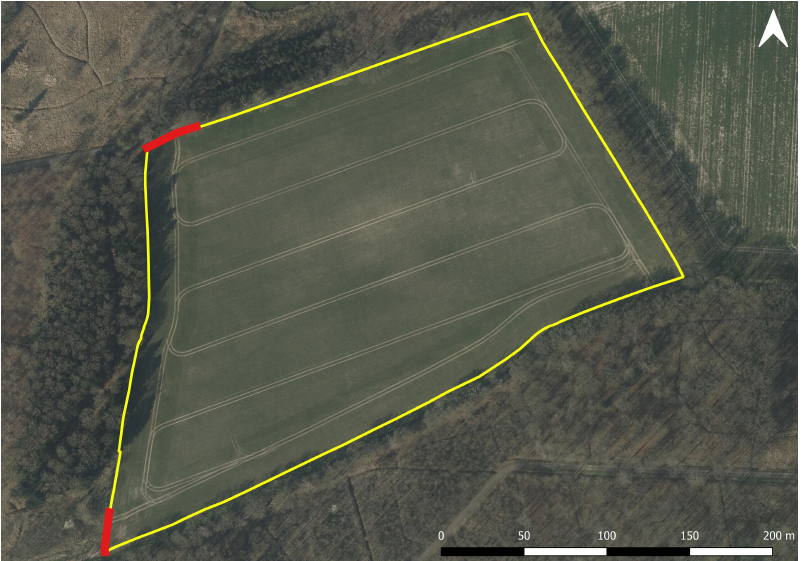
Figure 5. ( a ) Graph representation of a simplified field shape. ( b ) Field partitioning of the simplified field shape, showing the outer field boundary and field partitioning into main field and headland area. Two turn types, two headland tracks and five main field tracks are illustrated. Graph representation ( a ) and corresponding field partitioning ( b ) of a simplified field shape showing the complete grid of graph vertices (black dots) and arcs, i.e., all possible path networks, while the headland passes (’Headland arc’/’Headland pass’) and tracks (’Track arc’/’Track’) which in combination constitutes the area that must be covered by a field operation. The following abbreviations in combination explains the illustration of the generated output of all possible turning paths, connecting passes, and field access passes ( b ). T: main field track; H: headland; 2: maneuvering between; A: field access; CW: clockwise manoeuvre; CCW: counter clockwise manoeuvre.